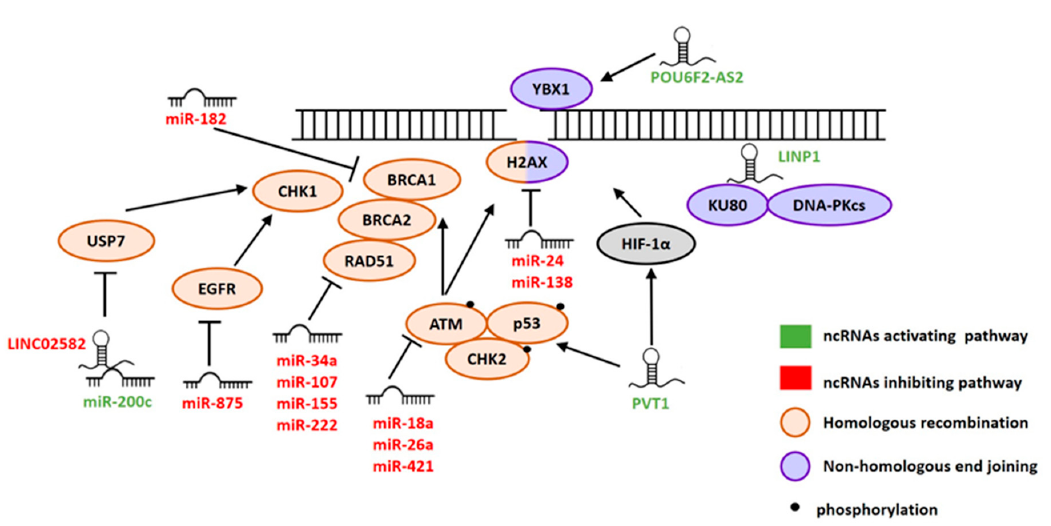
Figure 1. Non-coding RNAs (ncRNAs) regulating ionizing radiation (IR)-induced DSB repair. ncRNAs promoting (green) or inhibiting (red) DSB repair. The color of proteins indicates main pathways of DSB repair.